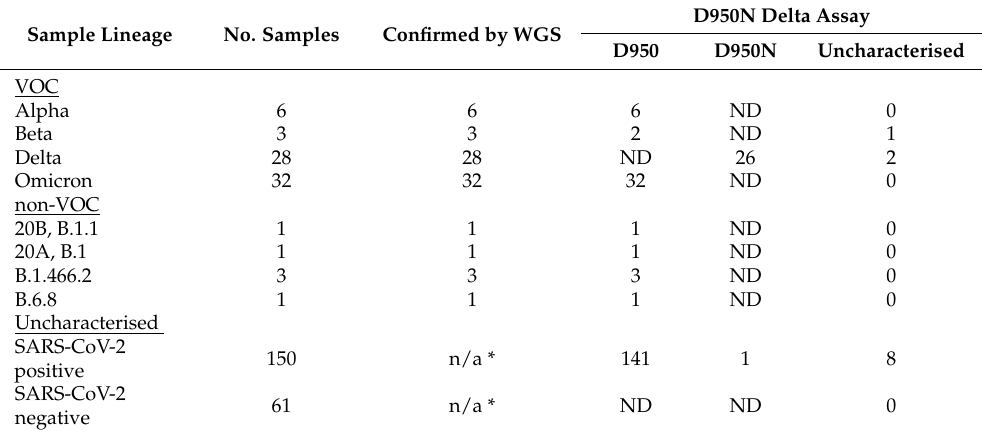
Table 2. Analytical specificity of the D950N Delta RT-PCR assay to screen for Delta